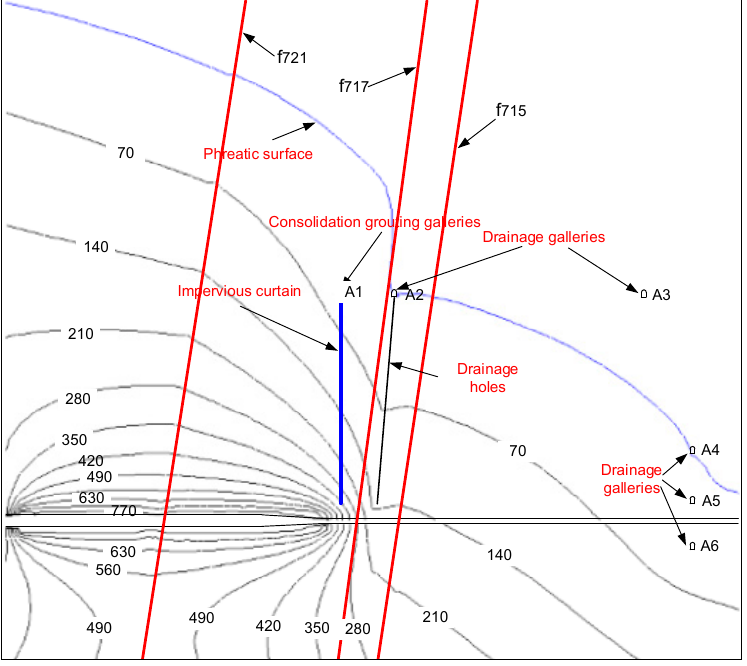
Figure 8. Phreatic surfaces and pressure distribution in the surrounding rocks at cross-section